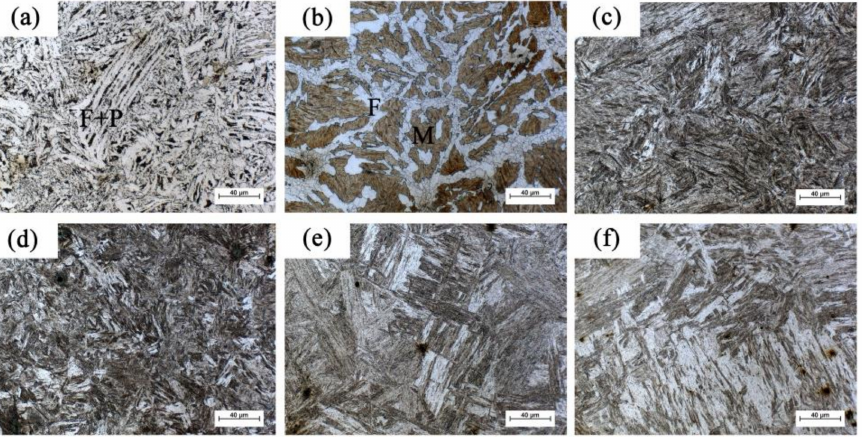
Figure 4. Microstructure of VL steel fractured at 600~1200 ◦ C with a strain rate of 10 − 3 s − 1 : ( a ) 600 ◦ C;